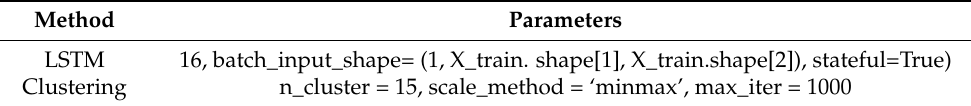
Table 7. Proposed models with specific